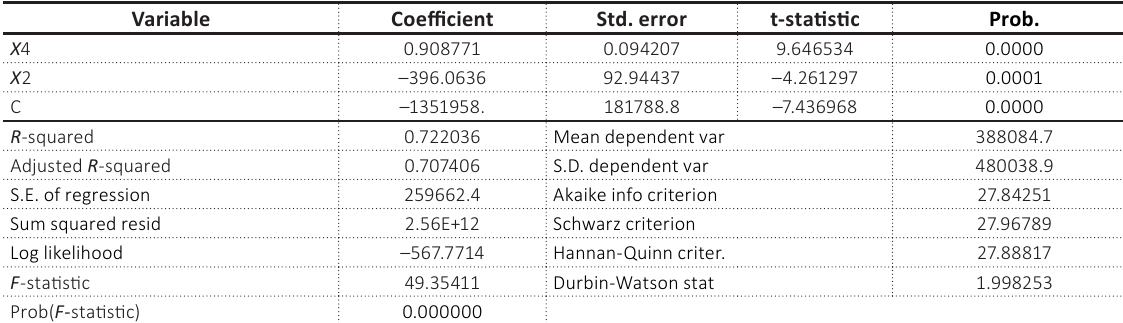
Table A1. Validity of the